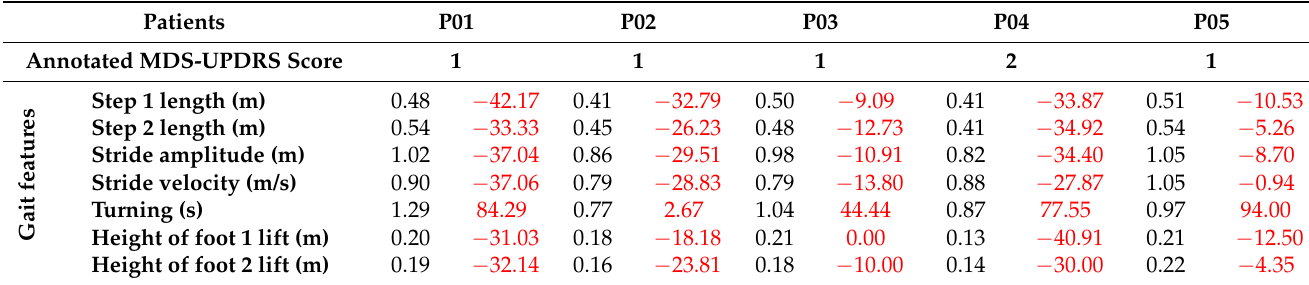
Table 2. Summary of gait features for the five PD subjects, with their annotated MDS-UPDRS scores. In red is the percentage deviation from the corresponding control subject.